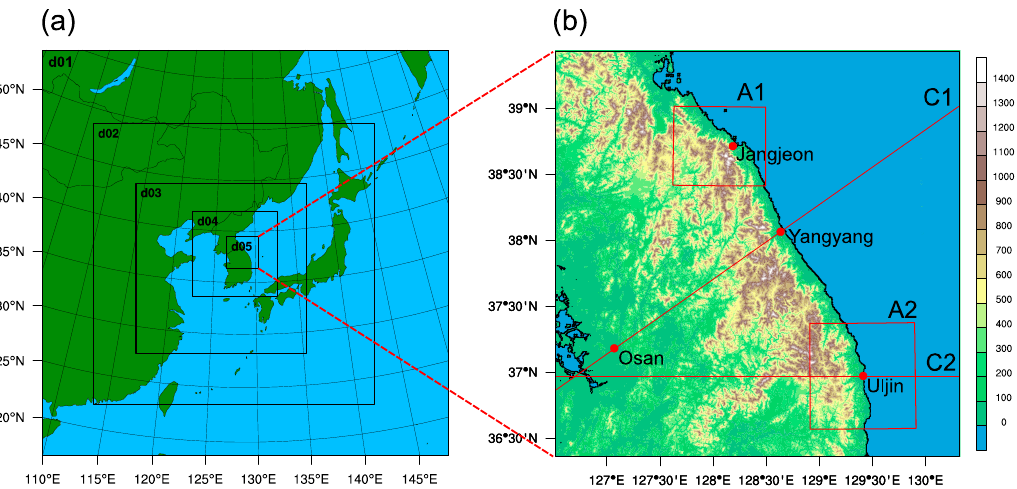
Figure 2. ( a ) Five nested domains and ( b ) terrain height (m) in the innermost domain (domain 5). The areas enclosed by the red lines, A1 and A2, include Jangjeon and Uljin stations. The red solid lines C1 and C2 are passing Yangyang and Osan stations and Uljin station, respectively.